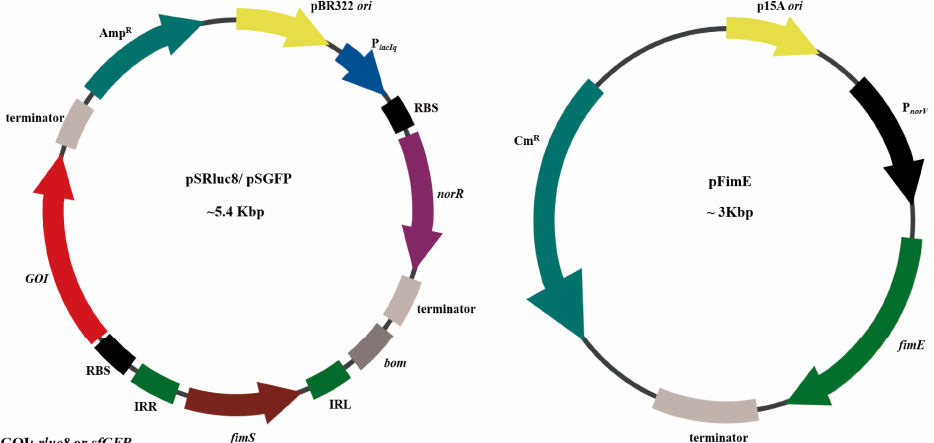
Figure 2. Plasmid construction. pSRluc8/pSGFP represents the plasmid containing the fimS switch block (IRR- fimS -IRL-RBS-GOI), which also constitutively expresses the NO sensor NorR, resulting in the repression of P norV . pFimE represents the plasmid for NO-induced FimE expression under the control of P norV , which is suppressed by NorR in the presence of low or no NO. ori , replication origin; RBS, ribosome binding site; IRL, inverted repeat left; IRR, inverted repeat right; Amp R , ampicillin resistance gene; Cm R , chloramphenicol resistance gene.